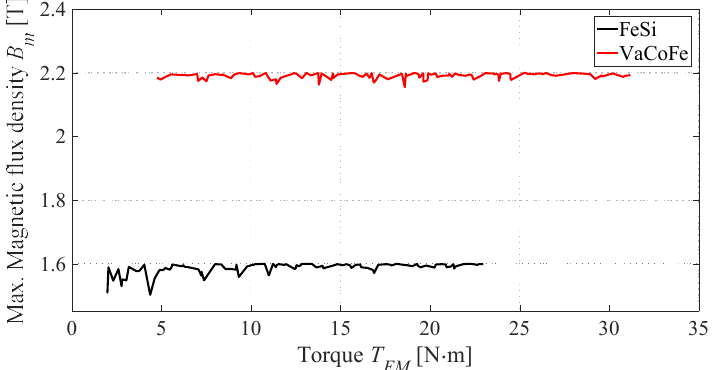
Figure 13. Surface and rotor temperatures of the last generation for FeSi and VaCoFe cores.